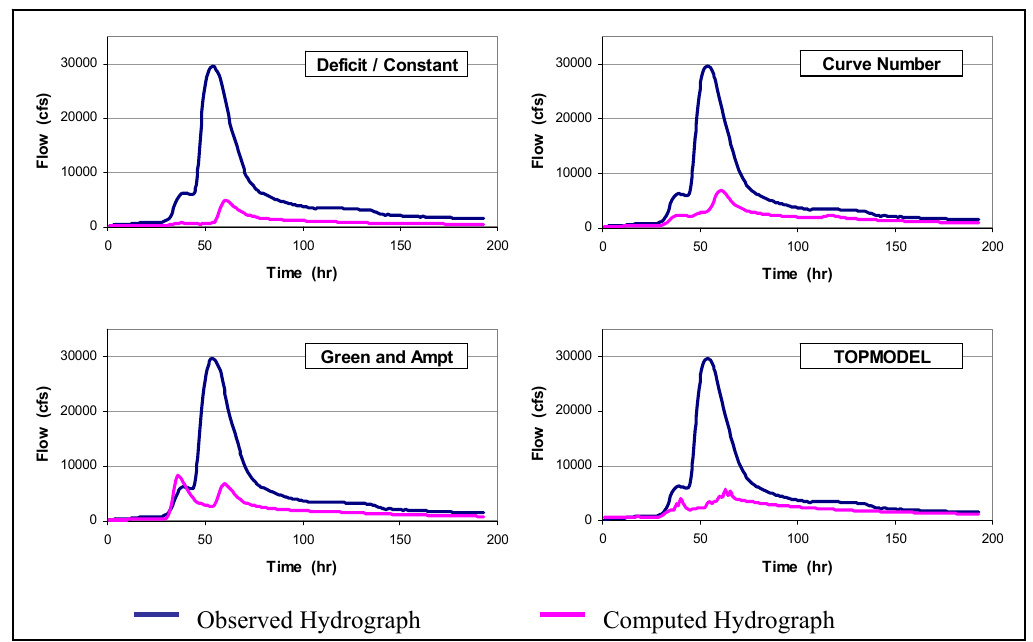
Figure 5. Computed vs. Observed Hydrographs using actual satellite rainfall data (unadjusted) at the native scale of 0.25 o